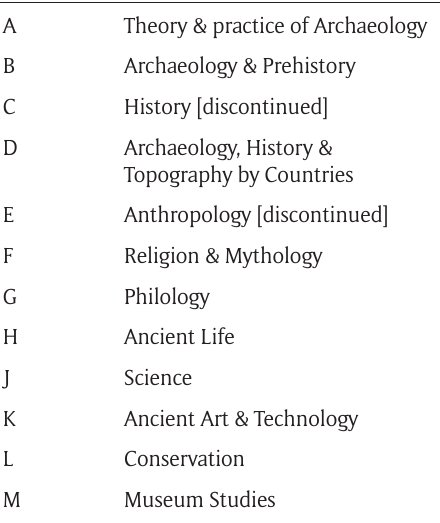
Table 2: Institute of Archaeology Library Classification Schemes (Meheux